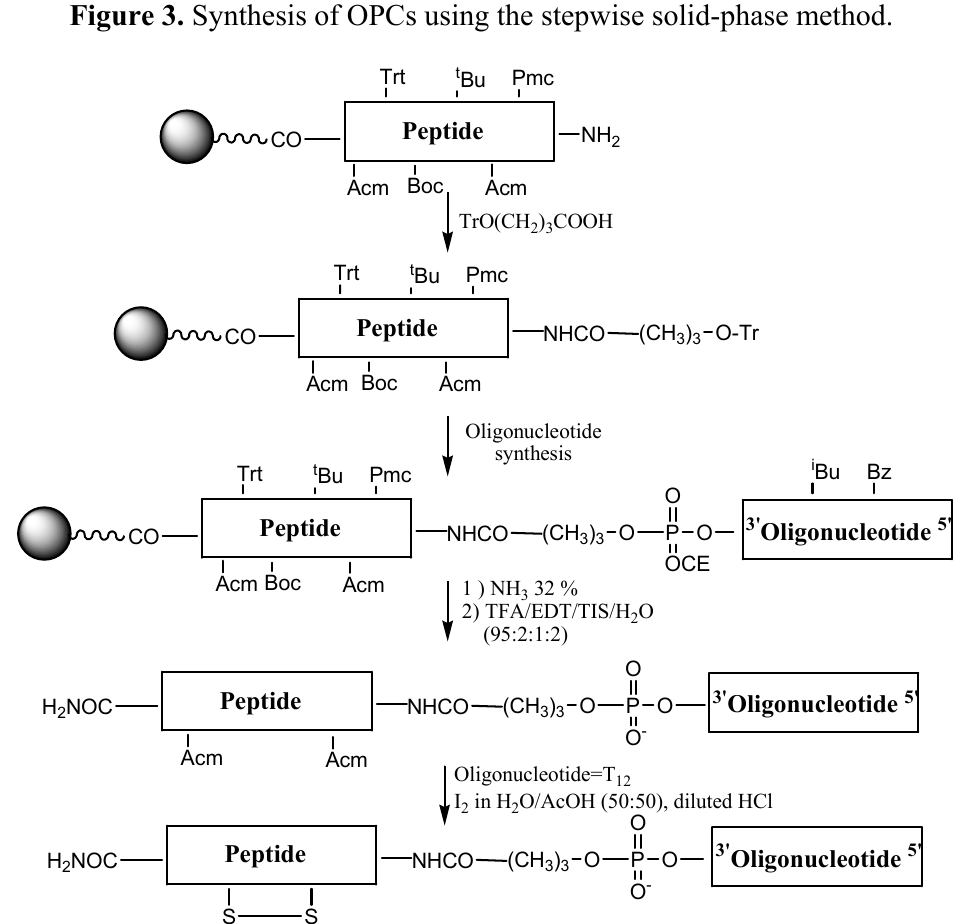
Figure 3. Synthesis of OPCs using the stepwise solid-phase